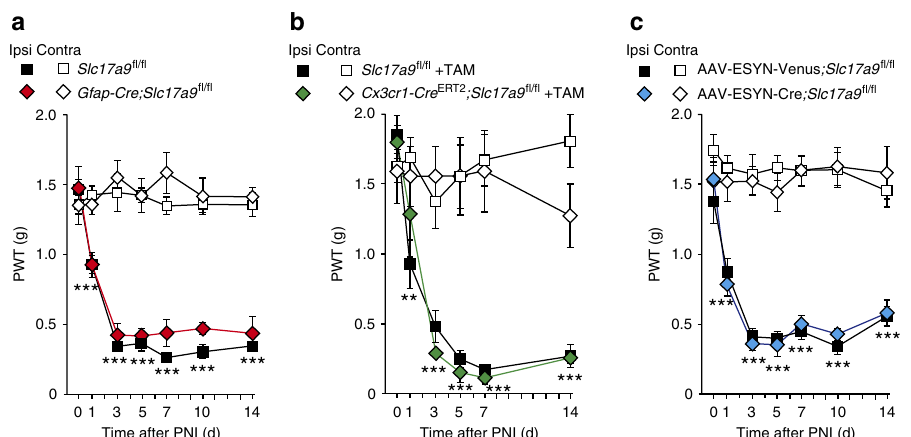
Figure 5 | Astrocytes, microglia and primary sensory neurons are not involved in VNUT-dependent neuropathic pain after PNI. ( a ) PWTof astrocyte- specific VNUT conditional knockout ( Gfap-Cre ; Slc17a9 fl/fl ) mice and their Slc17a9 fl/fl littermate controls before and after PNI ( n ¼ 6; *** P o 0.001 versus Contra ( Slc17a9 fl/fl ), two-way ANOVA with post hoc Bonferroni test). ( b ) PWTof microglia-specific VNUTconditional knockout ( Cx3cr1-Cre ERT2 ; Slc17a9 fl/fl ) mice and their Slc17a9 fl/fl littermate controls before and after PNI. Both genotypes were injected with tamoxifen (TAM) 5 weeks before PNI. ( Slc17a9 fl/fl : n ¼ 6, Cx3cr1-Cre ERT2 ; Slc17a9 fl/fl : n ¼ 5; ** P o 0.01, *** P o 0.001 versus Contra ( Slc17a9 fl/fl þ TAM), two-way ANOVA with post hoc Bonferroni test). ( c ) PWTof DRG neuron-specific VNUTconditional knockout (AAV-ESYN-Cre; Slc17a9 fl/fl ) mice and control AAV-ESYN-Venus; Slc17a9 fl/fl mice before and after PNI (AAV-ESYN-Venus; Slc17a9 fl/fl : n ¼ 8, AAV-ESYN-Cre; Slc17a9 fl/fl : n ¼ 7; *** P o 0.001 versus Contra (AAV-ESYN-Venus; Slc17a9 fl/fl ), two-way ANOVA with post hoc Bonferroni test). Values are means ±